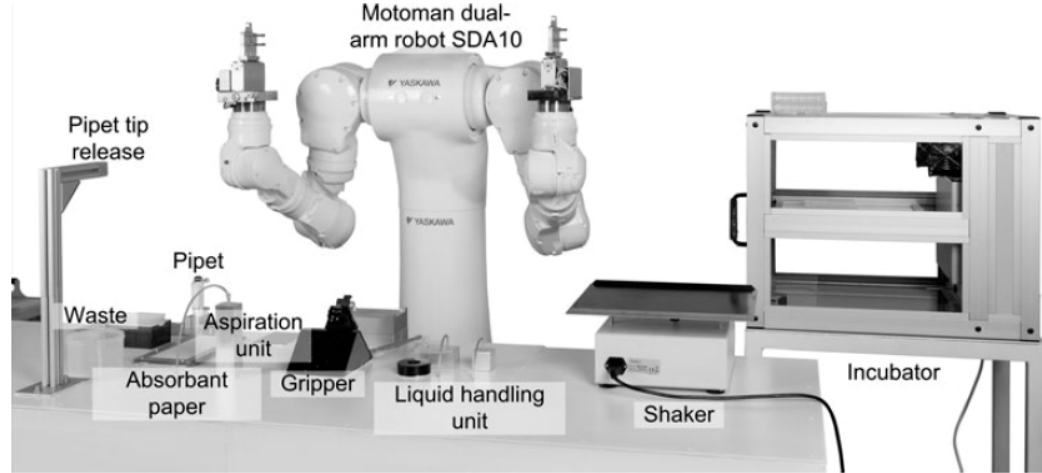
Figure 4. Execution of manual laboratory work by robot [38].